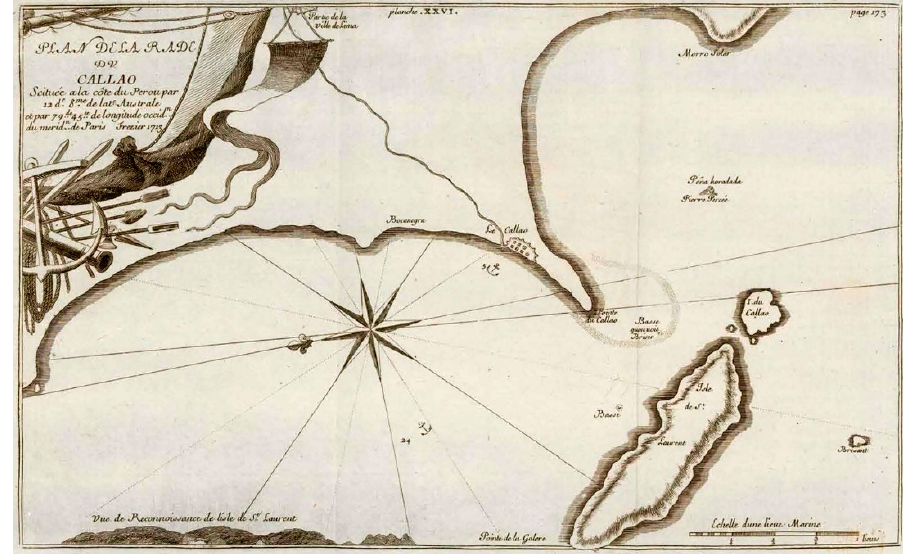
Figure 6. The bay of Callao and Isla San Lorenzo in a map surveyed by Frézier [28] in 1713 and published in 1716. Courtesy: Zentralbibliothek, Zürich.